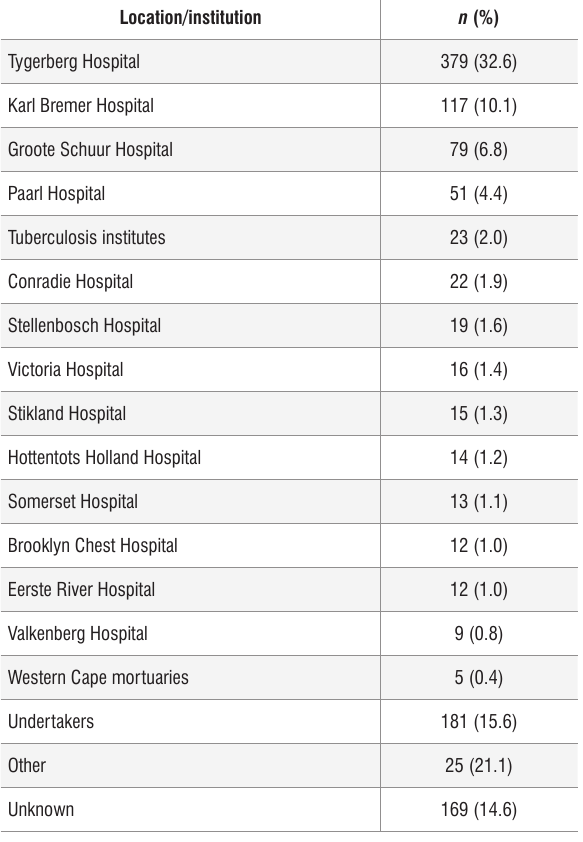
Skeletal Collection